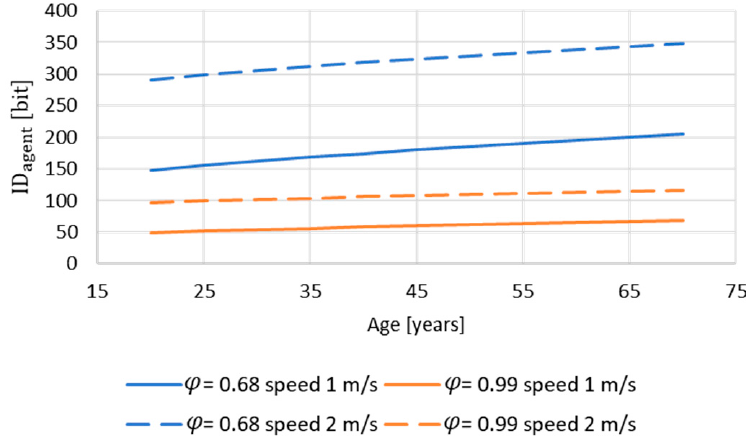
In Figure 9, ID agent ( ϕ , Speed , Age ) is plotted against the age of the subjects for differ- ent speed and ϕ values.